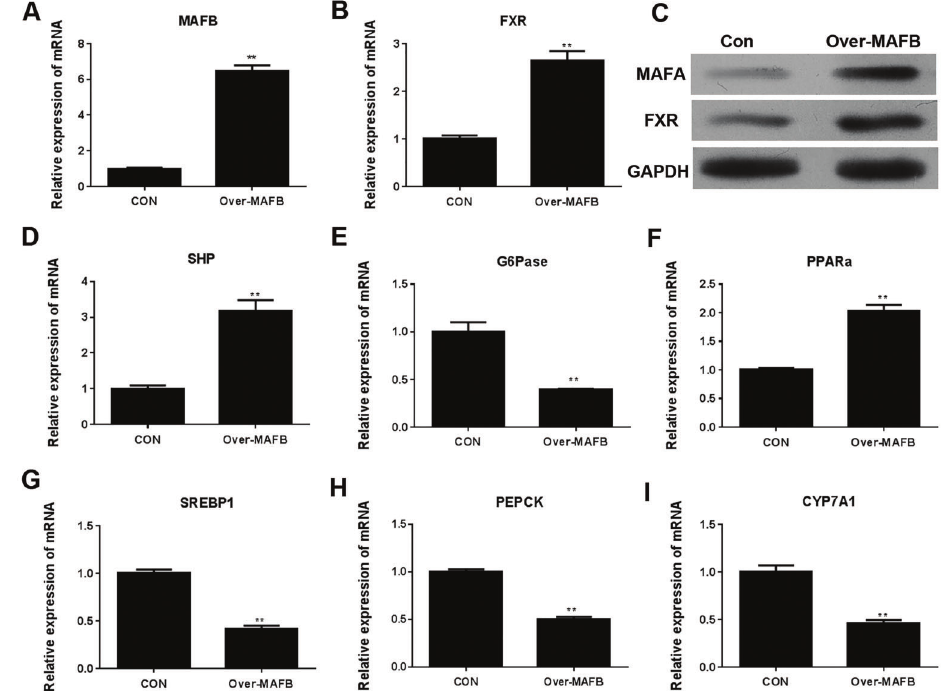
Figure 5. mRNA levels of MAFB ( A ) and FXR ( B ) in Chang liver cells overexpressing MAFB gene (over-MAFB) were analyzed by quantitative RT-PCR and by western blotting ( C ). The mRNA levels of SHP ( D ), G6Pase ( E ), PPAR a ( F ), SREBP ( G ), PEPCK ( H ), and CYP7A1 ( I ) were analyzed by quantitative RT-PCR. GAPDH was applied as the internal control in qRT-PCR analysis. Con: control group; FXR: farnesoid X receptor; SHP: small heterodimer partner; SREBP-1: sterol regulatory element binding protein-1; CYP7A1: cholesterol 7 a -hydroxylase gene (CYP7A1); PEPCK: phosphoenolpyruvate carboxykinase; G6Pase: glucose-6-phosphatase; PPAR a : peroxisome-proliferator-activated receptor a . Data are reported as means ± SD. **P o 0.01 ( t -test).